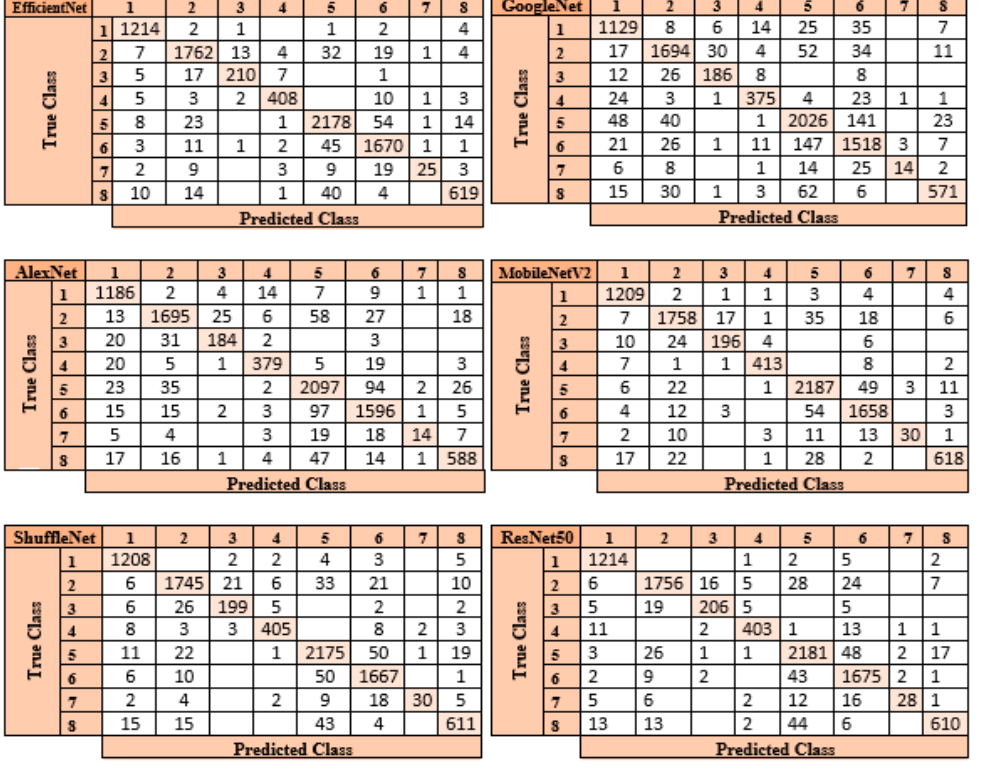
Figure 7. Confusion matrices of the Pre-trained Models+ SVM + Classifiers.